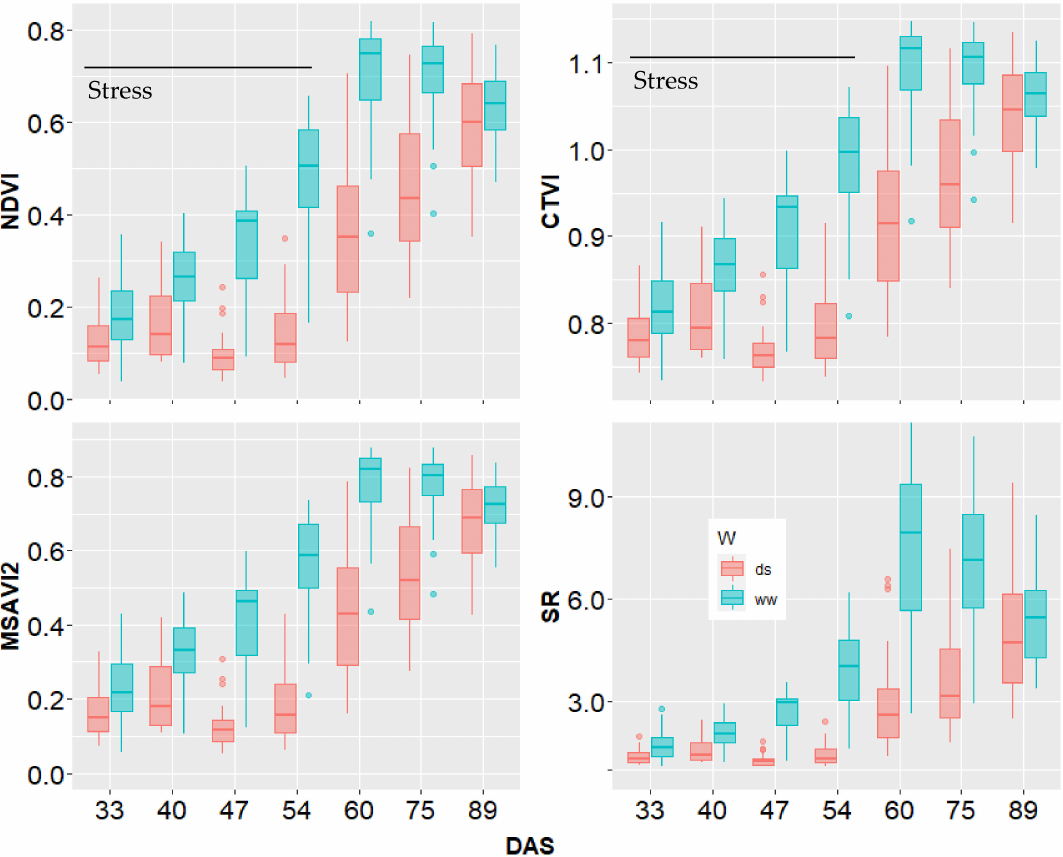
Figure 8. Dynamics of estimated vegetation indices under well-watered and drought stress conditions. Box plots gather estimations for the 10 studied sorghum varieties at a given stage. NDVI, CTVI, MSAVI2 and SR: vegetation indices; DAS: days after sowing; W: water regime, ds: drought stress, ww: